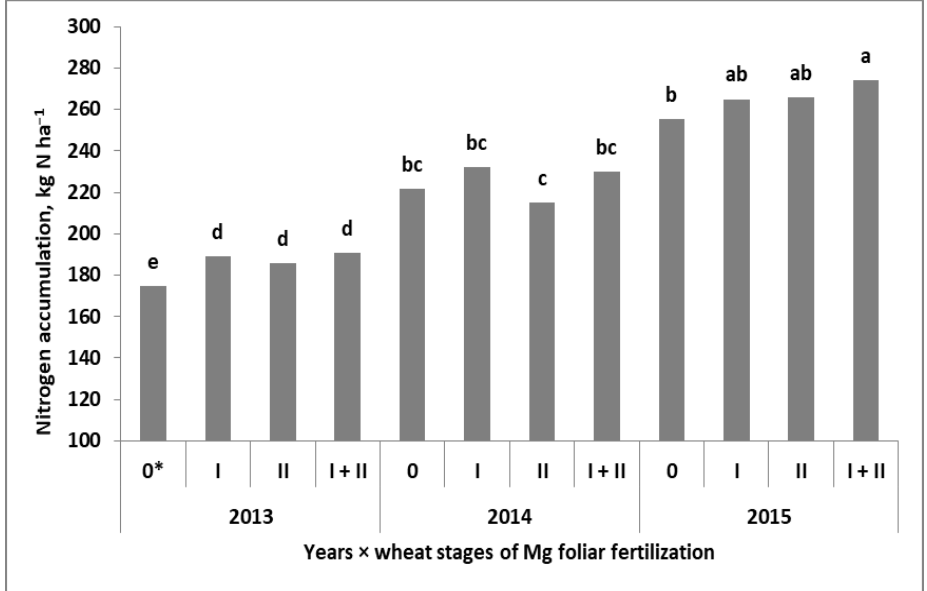
Figure 4. Effect of foliar fertilization of winter wheat with magnesium on nitrogen accumulation in grain. a, b, c, d, e Similar letters mean a lack of significant differences using Tukey’s test. Mgf—foliar Mg fertilization system. * Stages of Mg foliar fertilization to wheat: I — BBCH 30; II — BBCH 49/50.